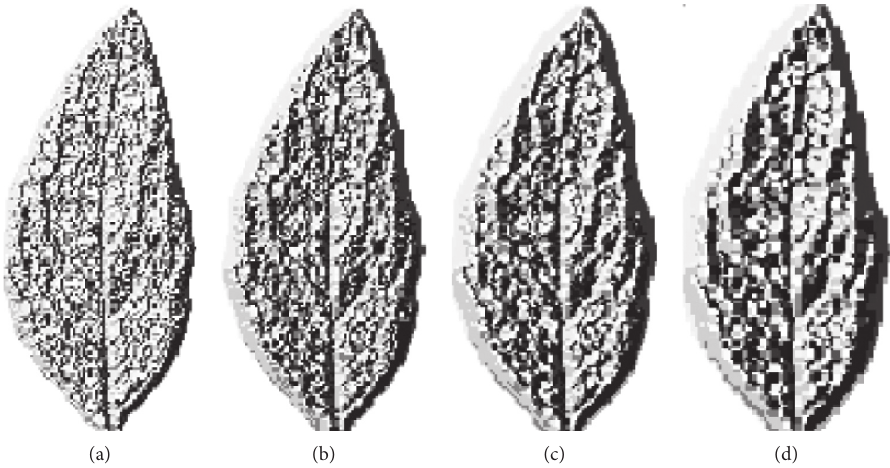
Figure 5: Leaf image encoded with BILBP (block numbers from 1 to 4, from left to right).